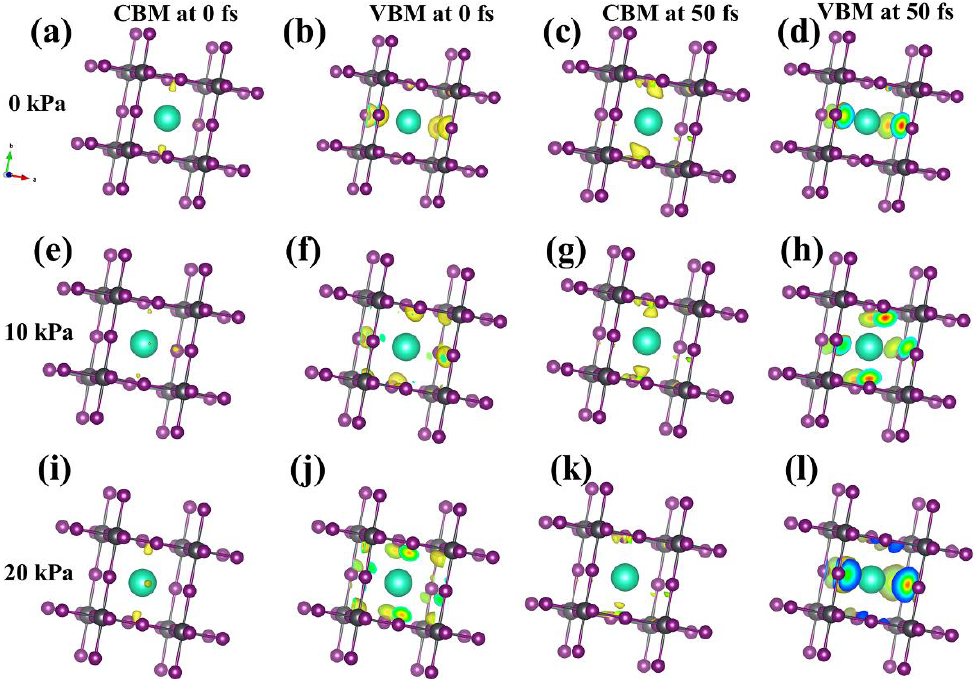
Figure 5. The evolution charge density distribution corresponding to the VBM and CBM of perovskite CsPbI 3 under pressure. ( a ), ( e ) and ( i ) represent the CBM under 0, 10 and 20 kPa at 0 fs, respectively. ( b ), ( f ) and ( j ) represent the VBM under 0, 10 and 20 kPa at 0 fs, respectively. ( c ), ( g ) and ( k ) represent the CBM under 0, 10 and 20 kPa at 50 fs, respectively. ( d ), ( h ) and ( l ) represent the VBM under 0, 10 and 20 kPa at 50 fs, respectively. The charge contours are set to a critical charge density of 0.0014 e Å -3 for CBM and 0.0043 e Å -3 for VBM.